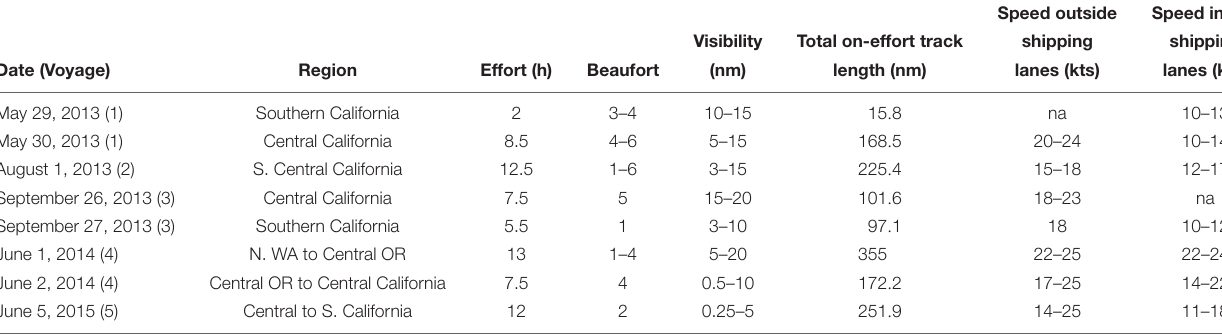
TABLE 2 | Dates, region, and on-effort length, sighting conditions, and speed of ship ride-alongs.